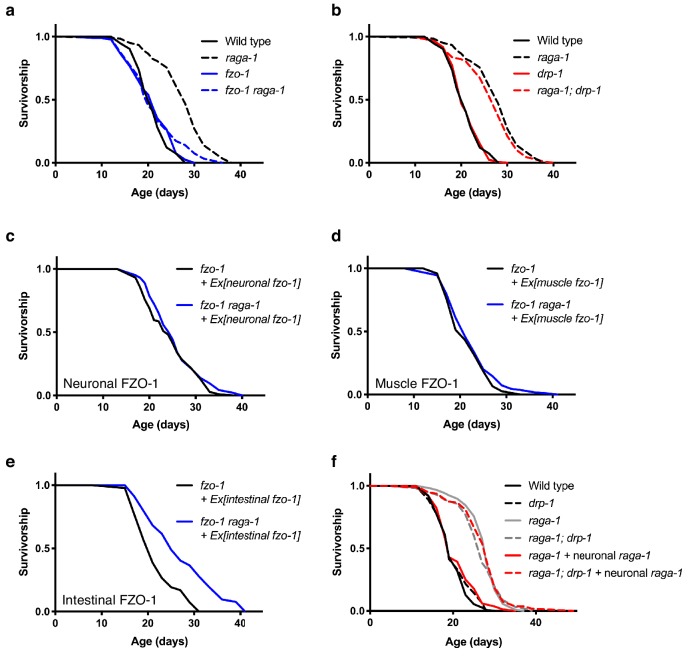
raga-1 deletion requires a fused mitochondrial network to promote longevity.(a) fzo-1(tm1133) raga-1(ok386) double mutants, which are deficient in mitochondrial fusion, have significantly shortened lifespan compared to raga-1(ok386) single mutants (p<0.0001). However, raga-1(ok386); drp-1(tm1108) double mutants, which are deficient in mitochondrial fission, have similar lifespan compared to raga-1(ok386) single mutants (p=0.1420) (b). n = 4 independent biological replicates; sample size ranges between 71–128 deaths per treatment each replicate. Lifespan curves in a and b were generated in the same experiment but plotted separately for clarity, therefore wild type and raga-1 control curves are shared by both. P values were calculated with Log-rank (Mantel-Cox) test. Details on strains and lifespan replicates can be found in Supplementary file 6. (c) When fzo-1 is rescued in the fzo-1(tm1133) loss-of-function mutants using the neuronal-specific rab-3 promoter, the lifespan extension by raga-1 deletion is not fully restored (p=0.0428). n = 3 independent biological replicates; sample size ranges between 71–101 deaths per treatment each replicate. P values were calculated with Log-rank (Mantel-Cox) test. Details on strains and lifespan replicates can be found in Supplementary file 6. (d) When fzo-1 is rescued in the fzo-1(tm1133) loss-of-function mutants using the muscle-specific myo-3 promoter, the lifespan extension by raga-1 deletion is not restored (p=0.2011). n = 3 independent biological replicates; sample size ranges between 77–95 deaths per treatment each replicate. P values were calculated with Log-rank (Mantel-Cox) test. Details on strains and lifespan replicates can be found in Supplementary file 6. (e) When fzo-1 is rescued in the fzo-1(tm1133) loss-of-function mutants using the intestinal-specific ges-1 promoter, the lifespan extension by raga-1 deletion is fully restored (p<0.0001). n = 3 independent biological replicates; sample size ranges between 43–104 deaths per treatment each replicate. P values were calculated with Log-rank (Mantel-Cox) test. Details on strains and lifespan replicates can be found in Supplementary file 6. (f) The drp-1(tm1108) deletion allele significantly extends lifespan in raga-1 neuronal rescue background (p<0.0001), but not in wild type (p=0.3440) or raga-1 mutant animals (p=0.4934). n = 4 independent biological replicates; sample size ranges between 78–120 deaths per treatment each replicate. P values are calculated with Log-rank (Mantel-Cox) test. Details on strains and lifespan replicates can be found in Supplementary file 6.